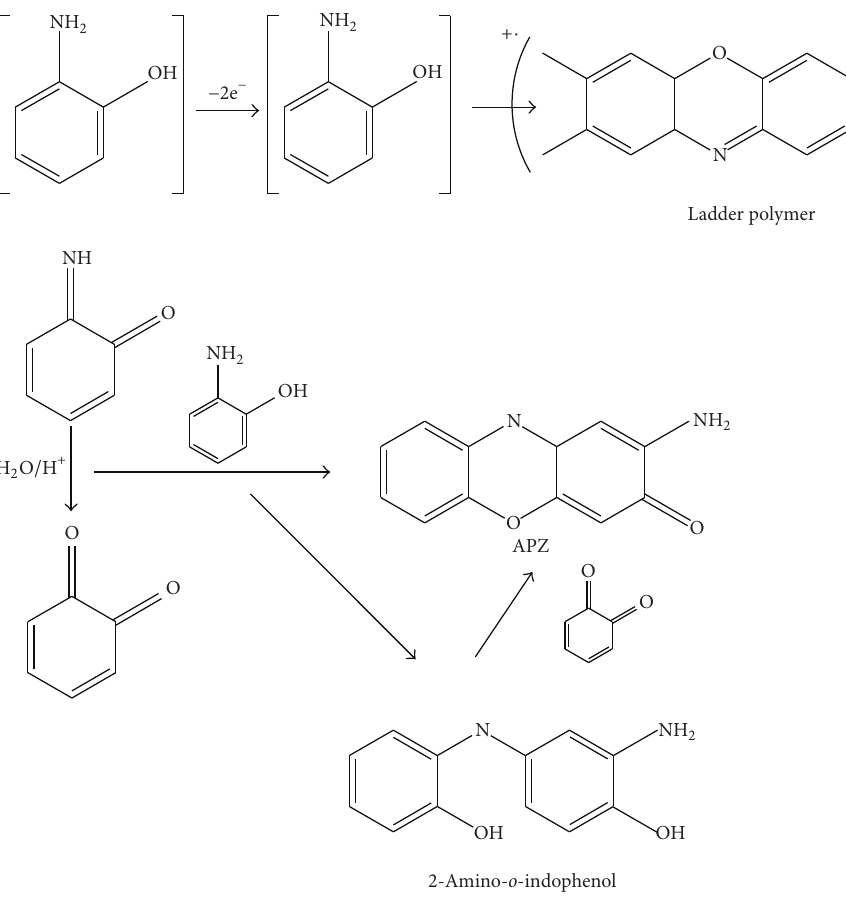
F 9: Mechanism of o -AP electro-oxidation in aqueous acidic medium